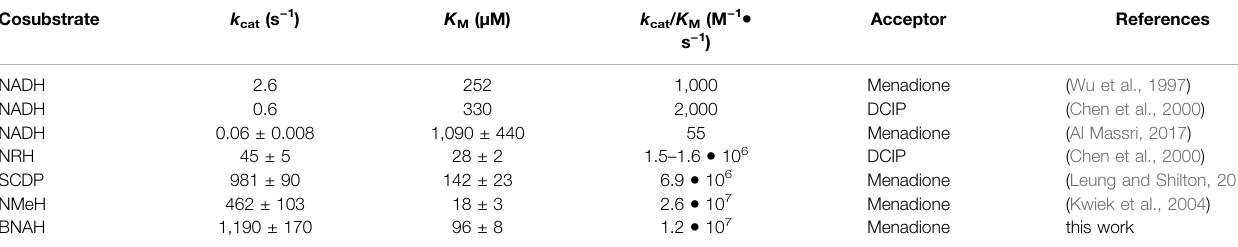
TABLE 1 | Steady-state kinetic parameters for cosubstrate use by human NQO2.